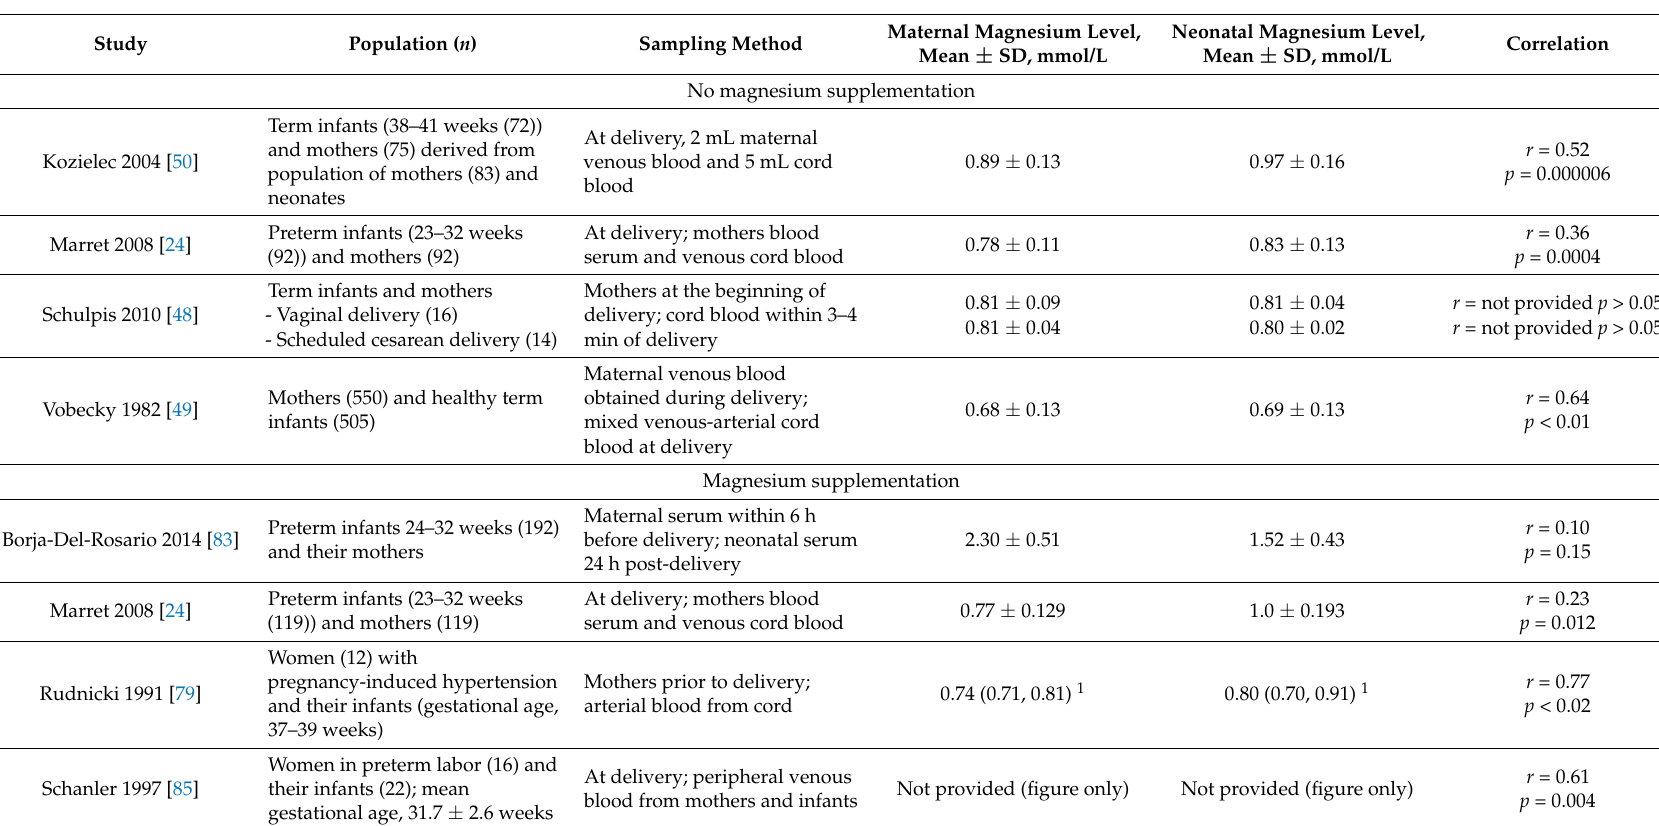
Table 1. Studies reporting relationship between maternal and umbilical cord blood and/or serum magnesium concentrations in newborns without and with magnesium supplementation during